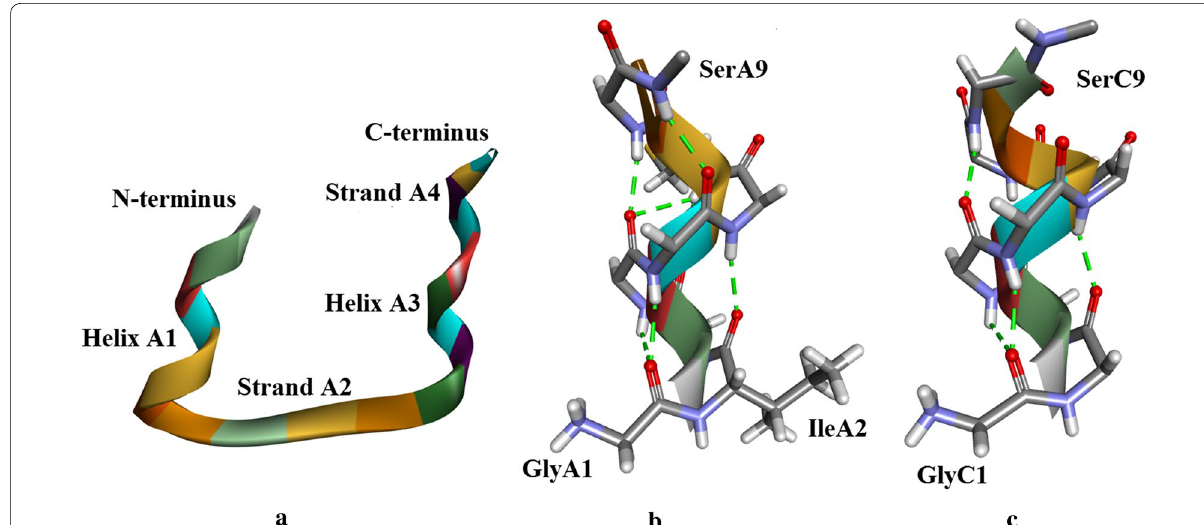
Fig. 4 a Insugen (I) chain A, secondary structure motifs. b Insugen (I) Helix A1: GlyA1–SerA9. With the exception of side‑chains GlyA1 and IleA2 which are shown completely, only main chain atoms are shown. H‑bonds are shown as green dotted lines . Compare with Figure S9a which shows the same region in porcine insulin [1]. c Insugen (I) Helix A3: LeuA13–TyrA19. H‑bonds are shown as green dotted lines . Main chain atoms only are shown. Drawn with Biovia, Discovery Studio 2016 [35]